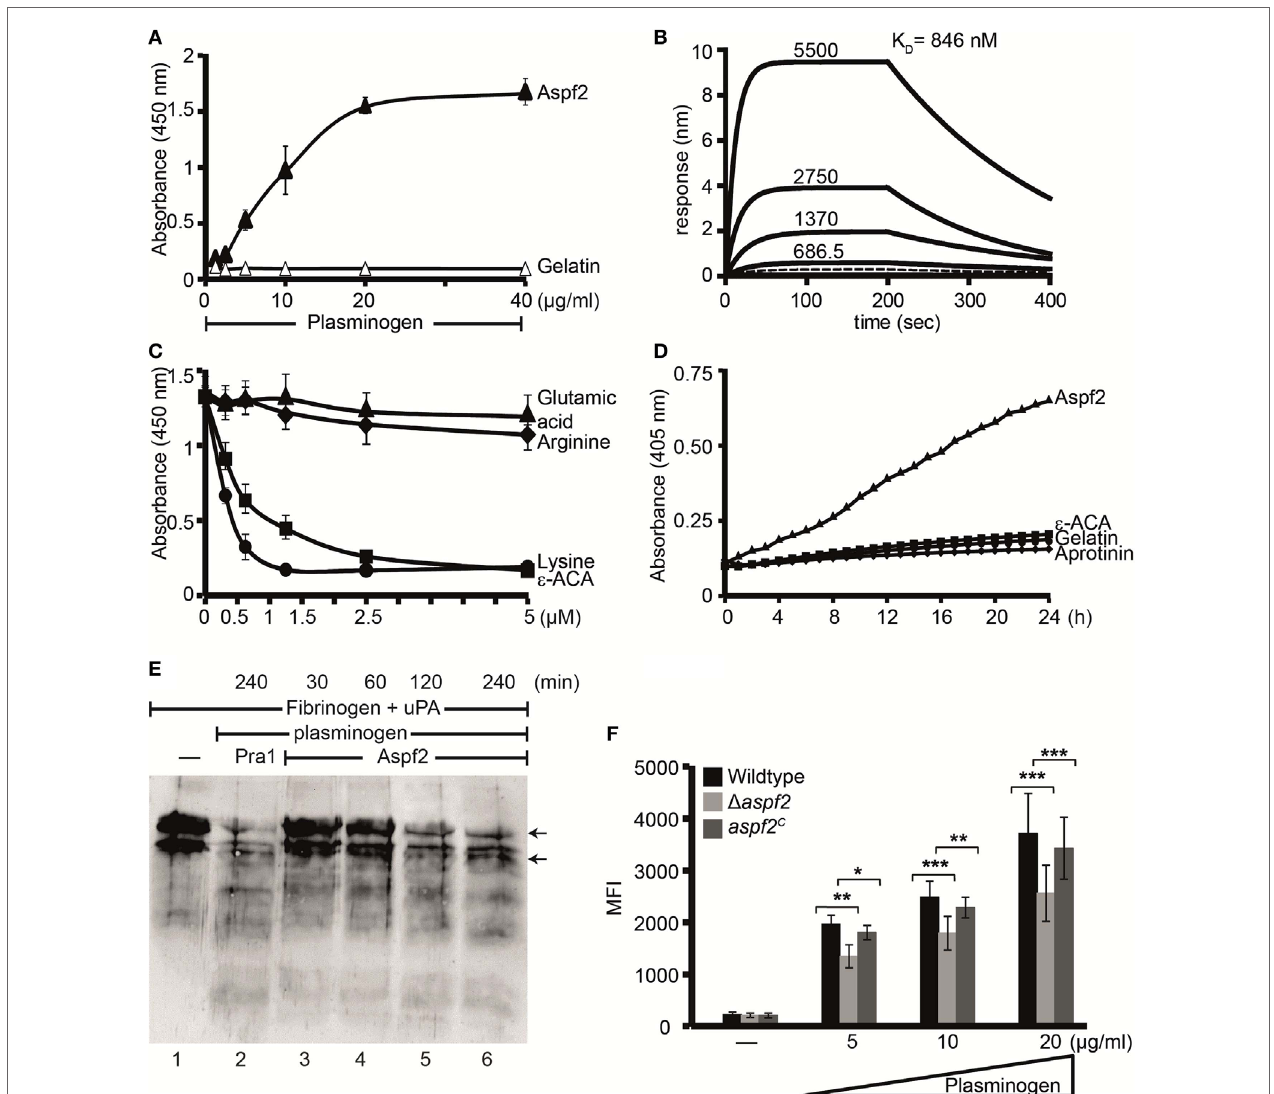
FigUre 6 | Plasminogen bound to Aspf2 is converted to active plasmin and bound to Δ aspf2 conidia with less intensity (a) Aspf2 binding to plasminogen was assayed by enzyme-linked immunosorbent assay (ELISA). Aspf2 at increasing amounts (0.125–4 µg) was added to immobilized plasminogen, and bound Aspf2 was detected with mouse mAb Aspf2. Aspf2 bound to plasminogen, and binding was dose dependent. Aspf2 did not bind to gelatin. (B) Plasminogen binds to Aspf2 with high affinity. The binding affinity of plasminogen to Aspf2 was evaluated by biolayer interferometry. Plasminogen at increasing concentration (687.5, 1370, 2,750, and 5,500 nM) was added to Aspf2 immobilized on Ni-NTA biosensors. For each concentration, the association was evaluated for 200 s. Following removal of the analyte, the complex dissociation was assessed for 200 s. Plasminogen bound to Aspf2 with a K D of 846 nM. Heat-inactivated (95°C) plasminogen did not bind to Aspf2 (bottom line). (c) The effect of lysine analog and free amino acids on plasminogen binding to Aspf2 was analyzed by ELISA. ϵ -aminocaproic acid ( ε -ACA), lysine, arginine, or glutamic acid, at the indicated concentrations, was added to plasminogen, and the mixture was added to immobilized Aspf2. Bound plasminogen was detected with HRP-conjugated anti-plasminogen antibody. ε -ACA and lysine blocked plasminogen binding to Aspf2. Positively charged arginine and negatively charged glutamine did not affect plasminogen binding to Aspf2. (D) Plasminogen bound to Aspf2 is converted into functionally active plasmin. Plasminogen was added to Aspf2 immobilized on microtiter plate, followed by urokinase-type plasminogen activator (uPA) and the substrate S-2251. The absorbance was recorded every 30 min over 24 h. Plasminogen when bound to Aspf2 was activated to plasmin which cleaved the chromogenic substrate S-2251 time-dependently. Aprotinin and ε -ACA inhibited cleavage of S-2251. When plasminogen, uPA, and S-2251 were added to immobilized gelatin, S-2251 remained intact and was not cleaved. (e) The fibrinolytic activity of Aspf2-bound plasminogen was investigated. Plasminogen was bound to immobilized Aspf2, and after washing, tissue-type plasminogen activator and fibrinogen were added. The reaction was stopped, and the proteins were separated by SDS-PAGE. Degradation of fibrinogen was assessed by Western blotting with a rabbit human fibrinogen antiserum. Plasminogen bound to Aspf2 was converted to plasmin which cleaved fibrinogen (lanes 3–6). When Pra1, a Candida immune evasive protein, was used as a positive control, plasmin generated from plasminogen cleaved fibrinogen (lane 2). Fibrinogen (upper arrow) and Fibrinogen degradation products (lower arrow). (F) Δ aspf2 conidia bind less plasminogen. Plasminogen was bound to Δ aspf2 , wild- type, and aspf2 C conidia. After washing, surface-bound plasminogen was detected by flow cytometry. When plasminogen was used at 20 µg/ml, Δ aspf2 conidia bound 24% less plasminogen as compared to wild-type and aspf2 C